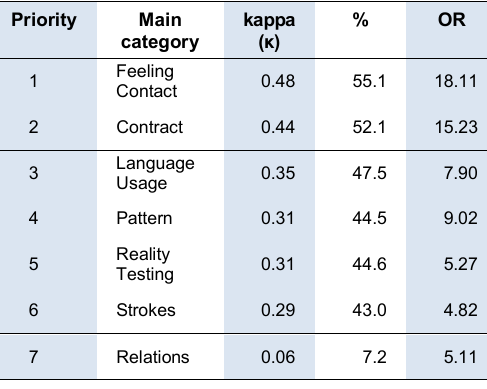
Table 9: Ranking of main category agreement